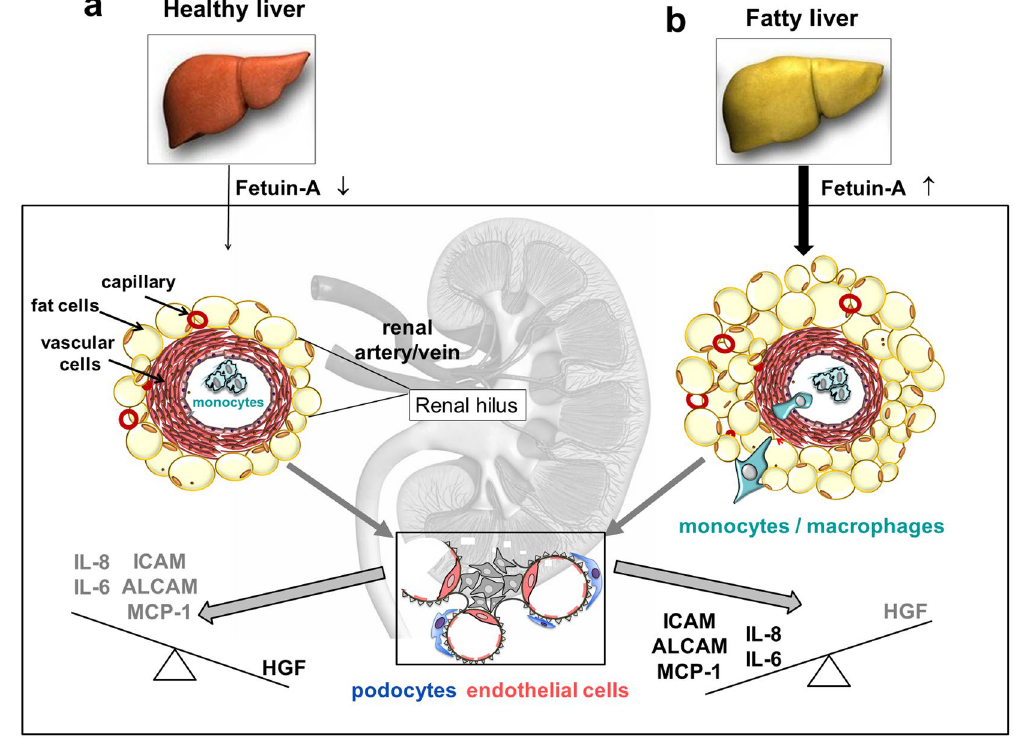
Figure 5. Proposed mechanism of the balance between RSFC-released (pro)-inflammatory cytokines and adhesion molecules, as well as the regenerative factor HGF (VEGF and the counterplayer TGF- β are not changed significantly and are therefore not shown for clarity). The crosstalk with the fatty liver via the increased hepatokine fetuin-A reversed the balance from a ( a ) ‘healthy’ to an ( b ) ‘unhealthy’ ((pro)-inflammatory and chemoattractive)